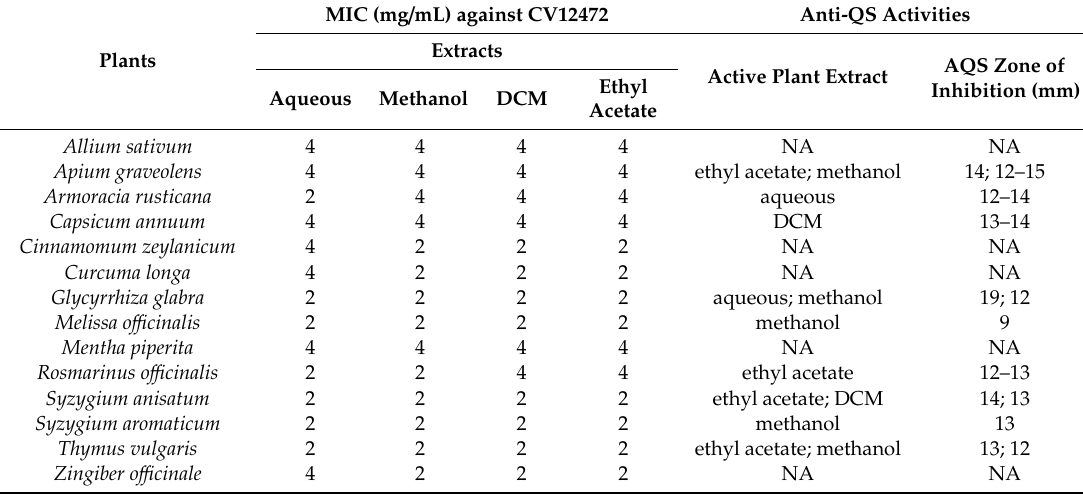
Table 4. Minimum inhibitory concentrations (MICs) (mg / mL) determined using the broth microdilution method, and anti-QS activities using the agar well di ff usion method of solvent extracts of various herbs and